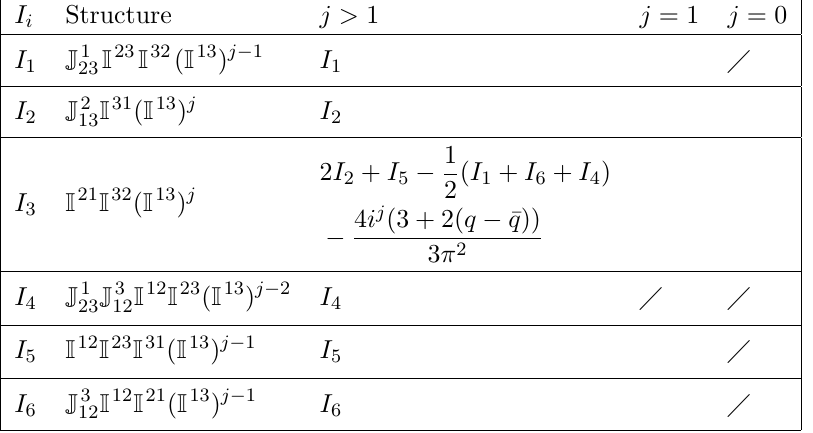
O 0 JO 0 when O 0 has spin ( 1 h i